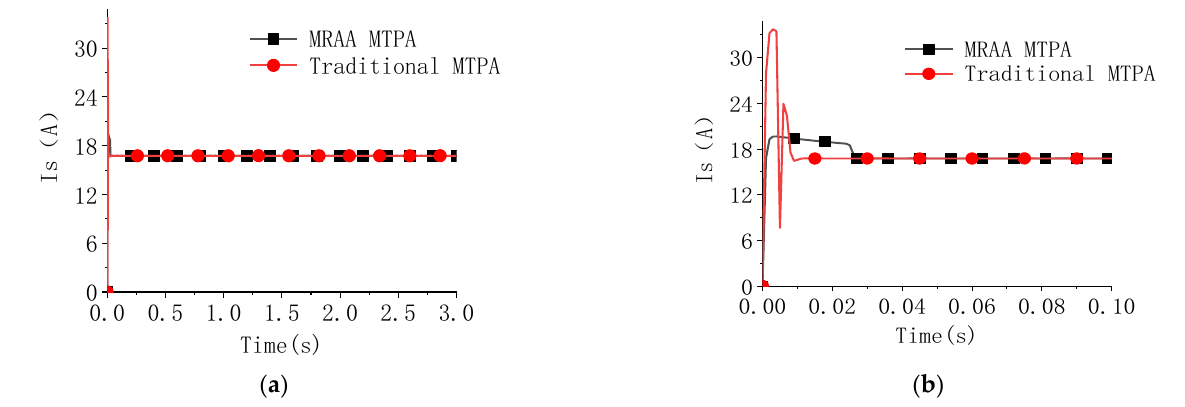
Figure 14. Comparison between MRAA-MTPA control and fixed-parameter MTPA control. ( a ) Comparison of stator current and ( b ) the local magnification of the starting segment.